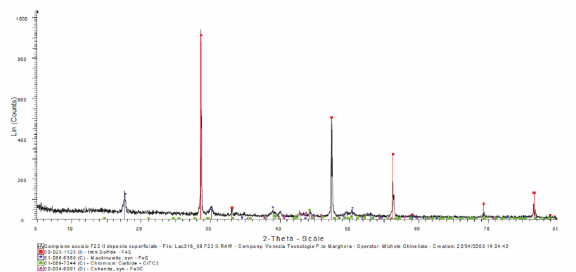
Figure 12: XRD pattern of corrosion products on sample